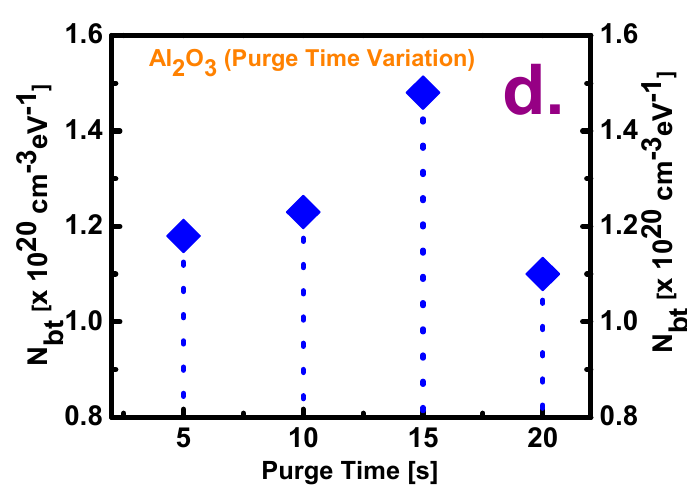
Figure 3. Best fitted curves of the measured capacitance values (symbols) and capacitance values calculated (dotted lines) for extracting the N bt using border trap model for films ( a ) deposited at three temperatures (200, 250, and 300 °C) with a purge time of 20 s and ( b ) deposited with four purge times (5 , 10, 15, and 20 s) with a deposition temperature of 250 °C. Border trap densities calculated under variations in ( c ) deposition temperature and ( d ) purge time.